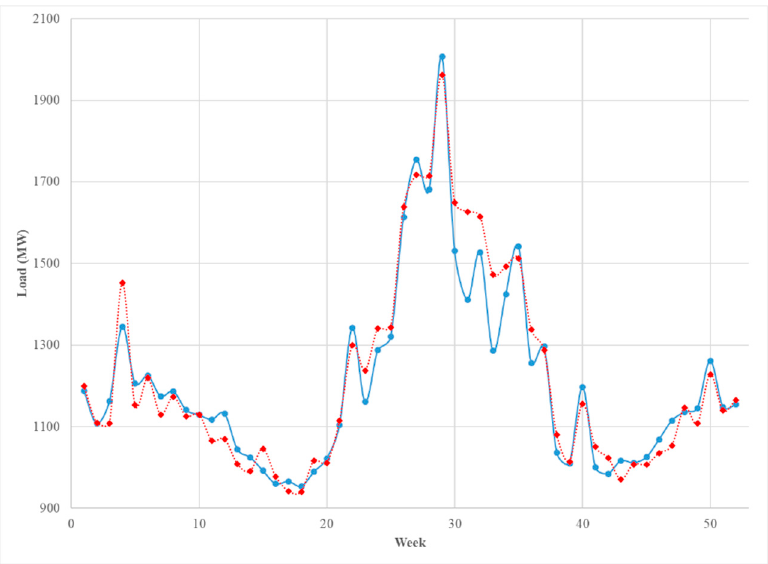
Figure 8. The weekly average of the hourly load (blue solid) and the predicted load (red dashed) in 2013.